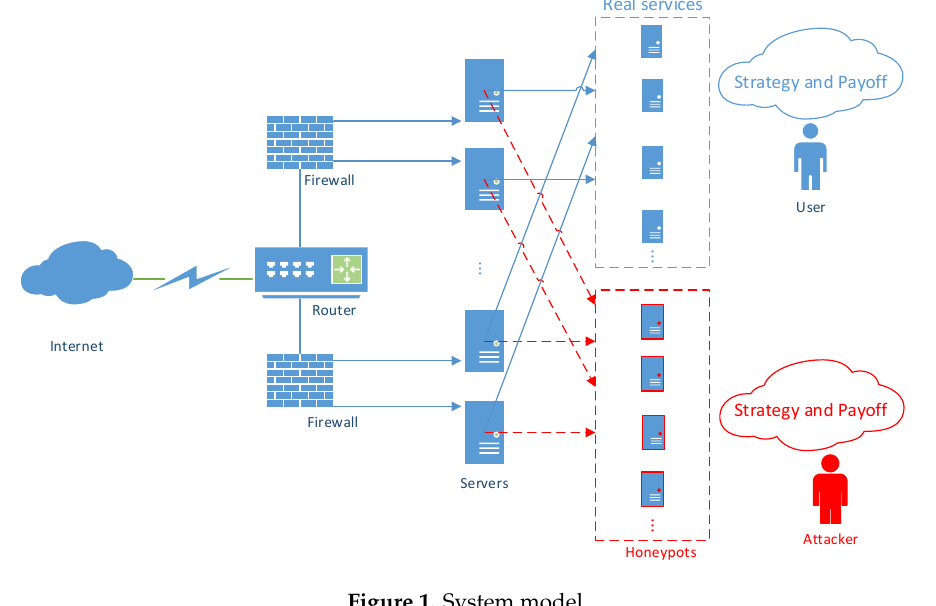
Figure 1. System model.